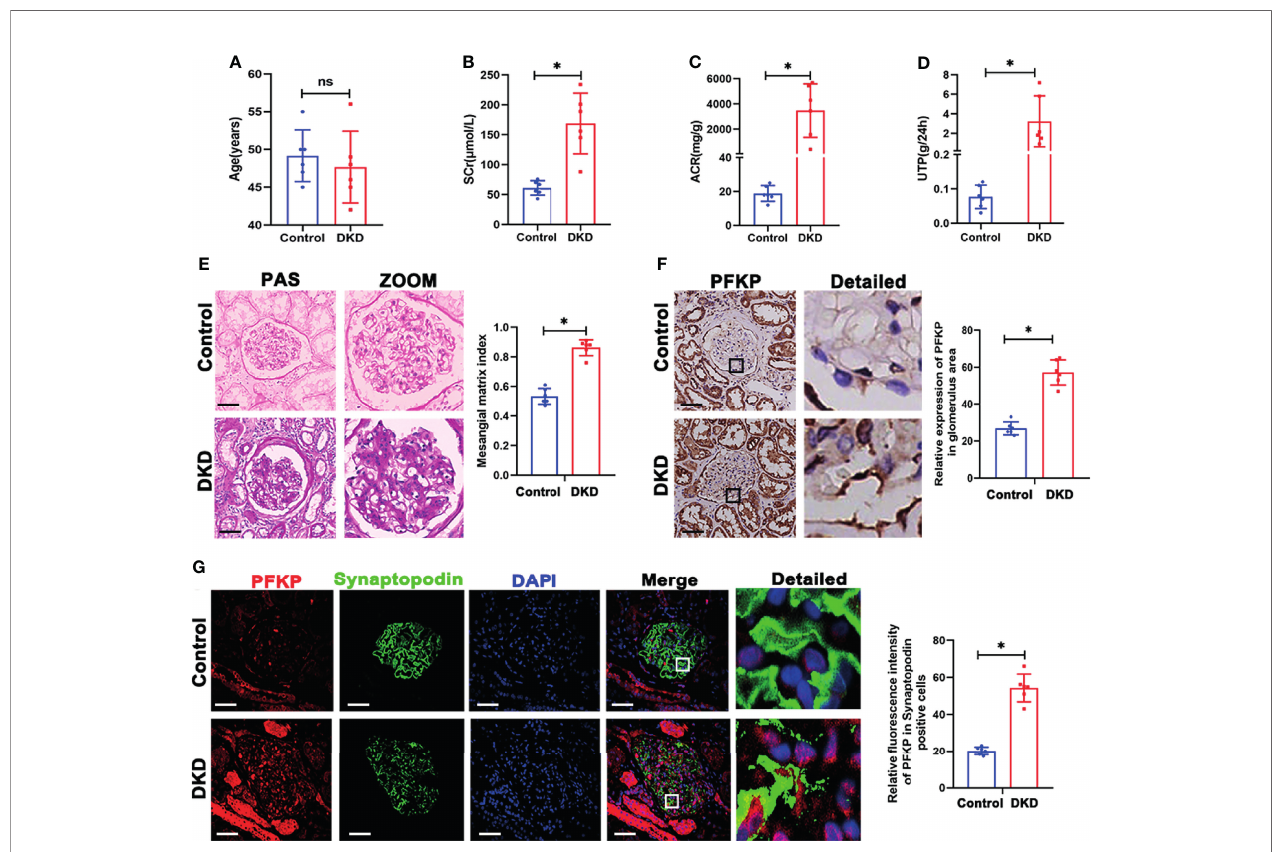
FIGURE 3 | PFKP expression in podocytes from patients with biopsy proved DKD. (A) Age of subjects in each group. (B) SCr values of subjects in each group. (C) ACR values of subjects in each group. (D) UTP values of subjects in each group. (E) Representative microscopy images and quanti fi cation of PAS staining of kidney sections in each group (original magni fi cation ×200). (F) Representative immunohistochemistry staining of glomerular PFKP in each group. (Original magni fi cation ×200). (G) Representative immuno fl uorescence staining of PFKP in podocytes in each group. Synaptopodin was used as podocyte markers. For all fi gures, n=6 independent experiments/group. In all statistical plots, * P < 0.05, ns, No signi fi cance. Scale bars: 20 µm, DKD, diabetic kidney disease; PFKP, Phosphofructokinase 1 platelet type; SCr, Serum creatinine; UTP, Total proteinuria; ACR, urine albumin/creatinine